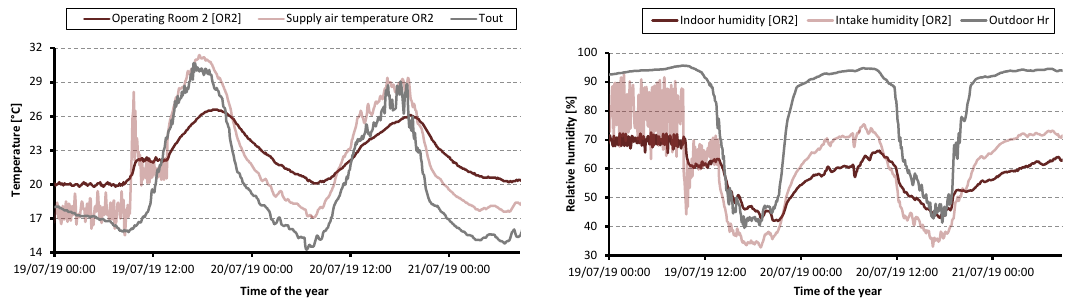
Figure 5. Temperature and RH from OR2 during the first experimental data campaign.